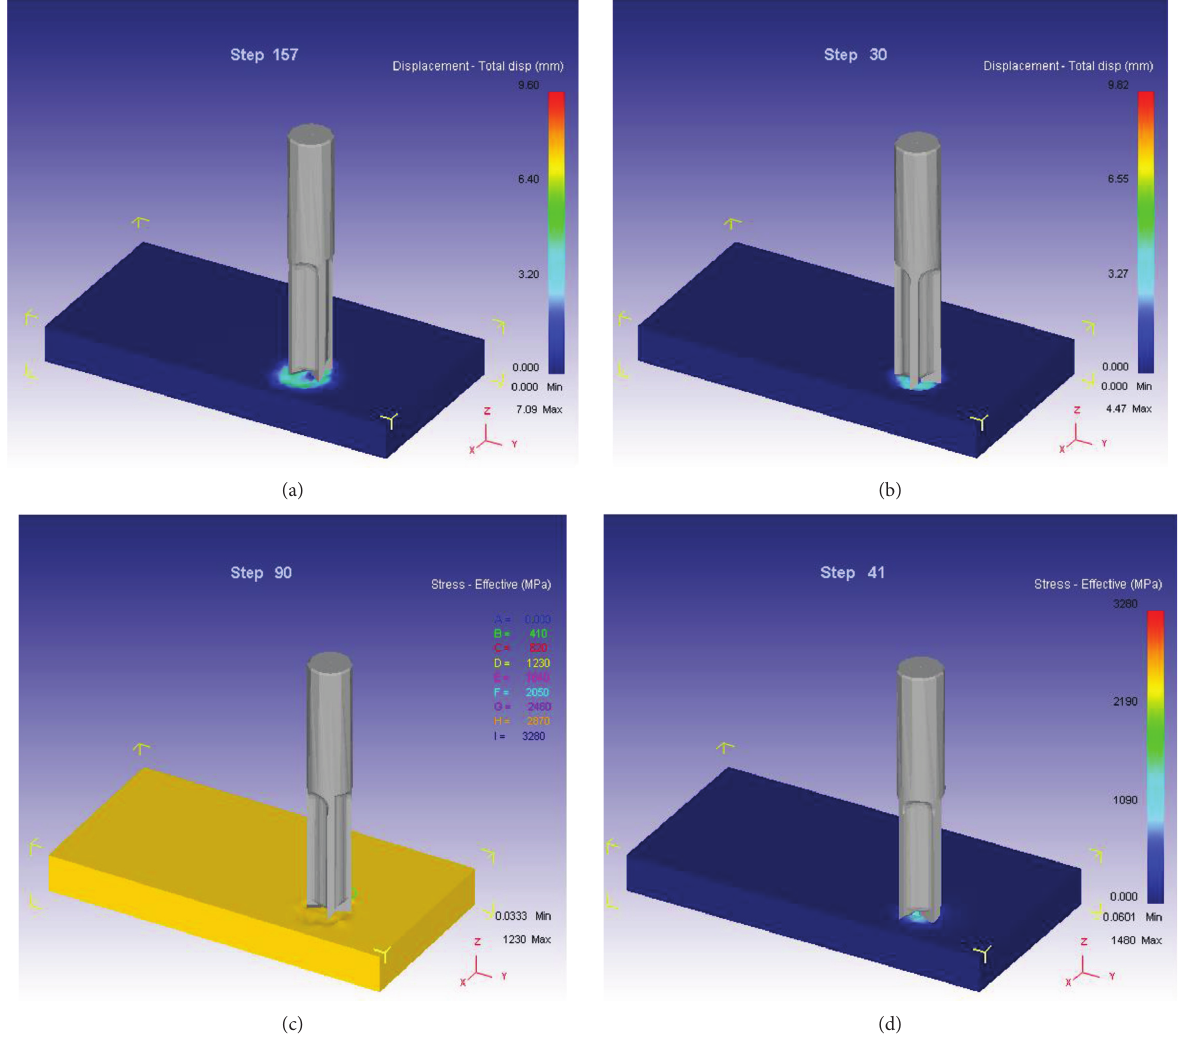
Figure 12: Deform simulation results of (a) higher displacement in step 157 of HSS-non-HT-2500rpm, (b) lower displacement in step 30 of WC-non-HT-2500rpm, (c) and (d) lower stress effective in step 90 and 41 of